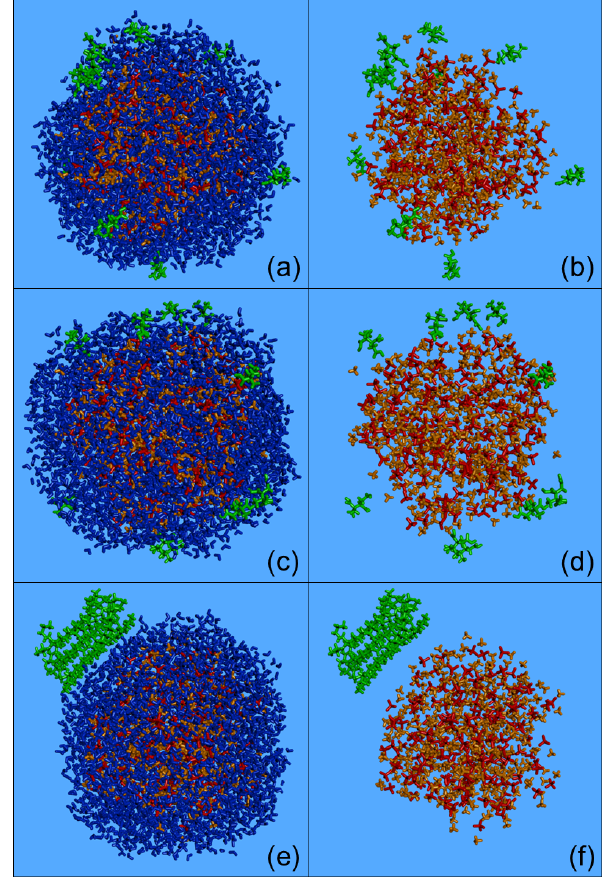
Figure 4. Characteristic snapshots from the MD simulations of the nanoparticles containing CPA (a, b) , MBTCA (c, d) and n - eicosane (e, f) at low organic mass fraction (7%–10%) and 89% RH, including (a, c, e) and omitting (b, d, f) water molecules. Colour coding: green for CPA, MBTCA and n -eicosane, red for sulfate, orange for ammonium and blue for